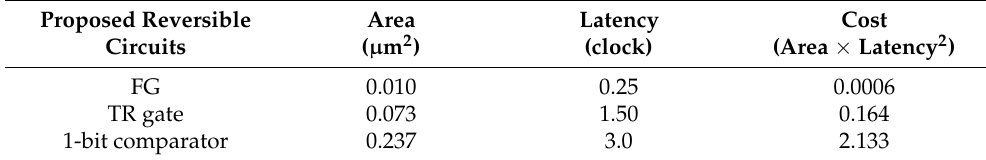
Table 5. Quantum cost for the proposed reversible circuits.